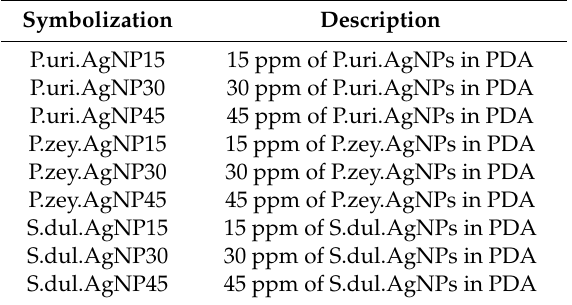
Table 1. The compositions of media prepared for antifungal assay. PDS = Potato dextrose agar,